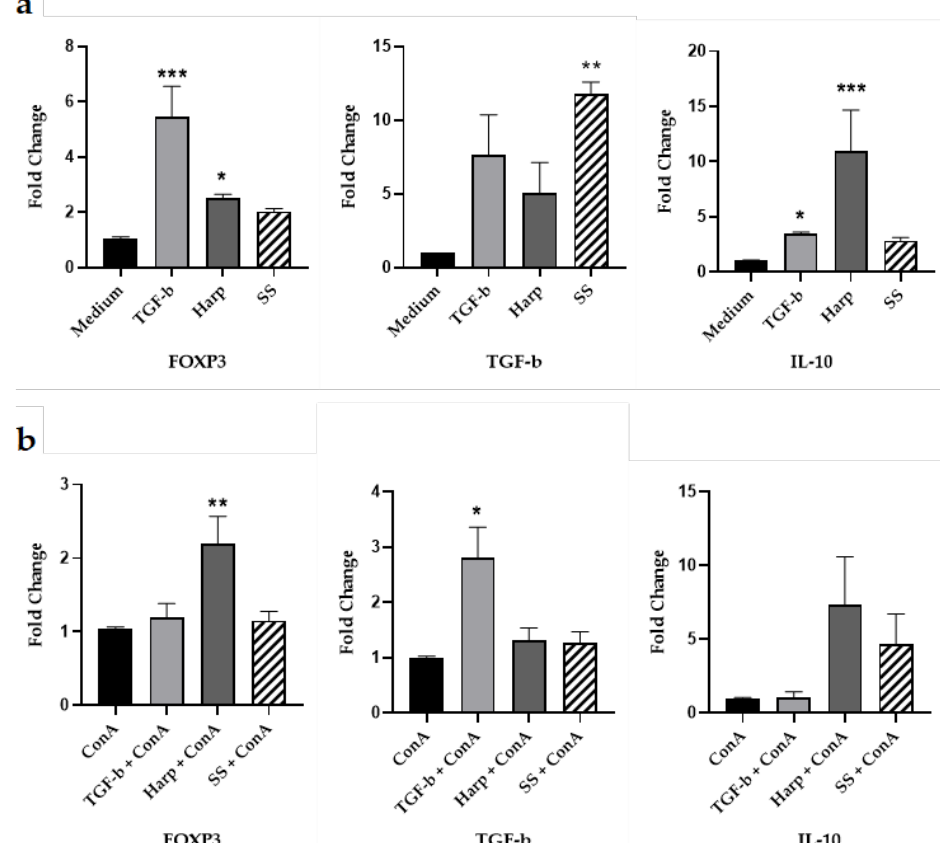
Figure 2. Changes in the FoxP3, IL-10 and TGF-β mRNA expression 5 days after addition of compounds. Peripheral blood mononuclear cells (PBMCs) were isolated and incubated without activation along with 10 ng/mL TGF-β, 1 μM Harp or 5 μM SS for 5 days. Fold difference in the expression of FoxP3, TGF-β and IL-10 mRNA: ( a ) Fold difference in the expression of mRNA in cells without ConA and ( b ) with ConA 5 μg/mL. Data shown are from one representative experiment out of three, showing fold change ± S.E. Statistical significance shown as expression compared with control PBMCs in medium alone for the non-activated PBMCs or with ConA alone for the activated PBMCs that are treated with Harp, SS or TGF-β cells (* p < 0.05, ** p < 0.005 and *** p < 0.0005). Data shown represent three biological replicates.